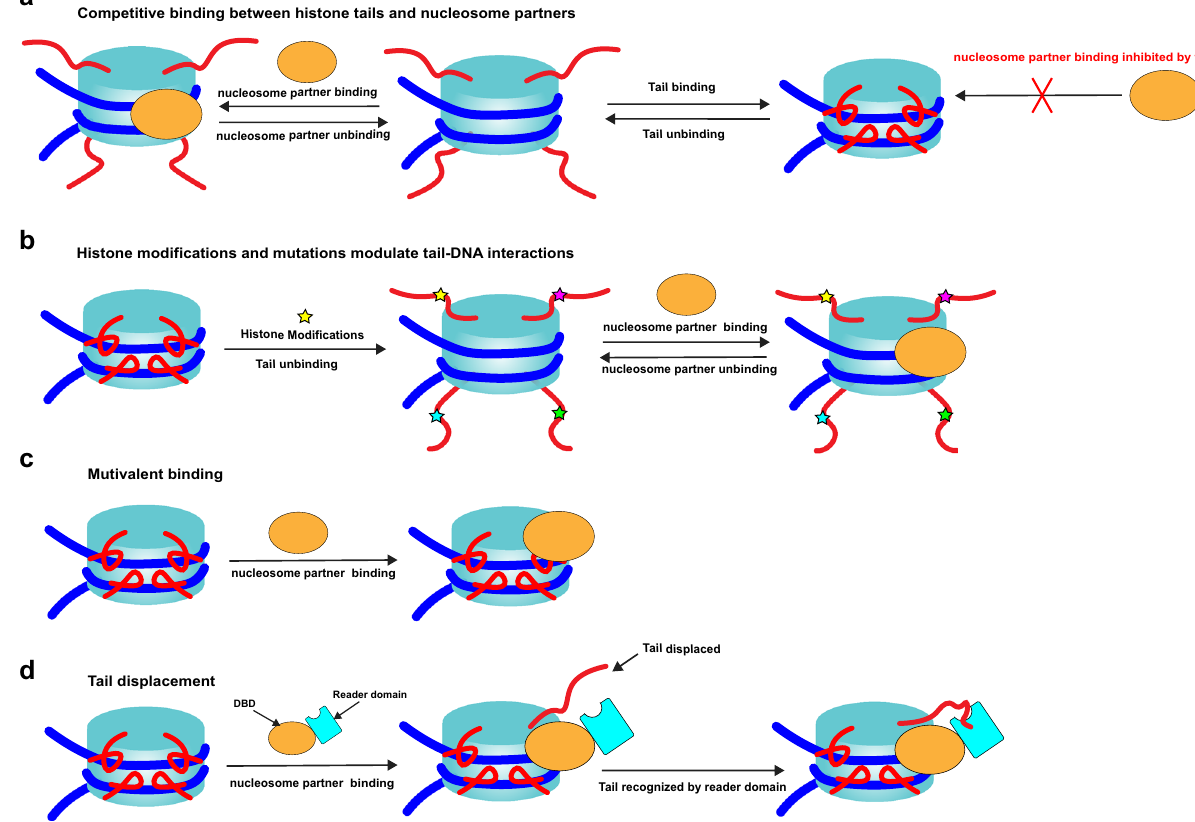
Fig. 6 A generalized model explaining how tails and their modi fi cations can modulate nucleosomes ’ interactions with nucleosome-binding proteins. a Histone tails ’ interactions with DNA may in some cases modulate the accessibility of DNA to binding partners; nucleosome-binding proteins compete with histone tails for binding to DNA. b Post-translational modi fi cations and mutations in histone tails can suppress tail – DNA interactions, enhance histone tail dynamics, and regulate the binding of proteins to nucleosomes. c Some nucleosome-binding proteins may exhibit multivalent binding modes and recognize both histones and DNA. d DNA-binding domains (DBDs) of nucleosome-binding proteins compete with histone tails if they recognize DNA and reader domains compete with DNA if they recognize tails; interactions of DBD with nucleosome can displace histone tails from their DNA preferred binding modes and increase their accessibility for recognition by reader